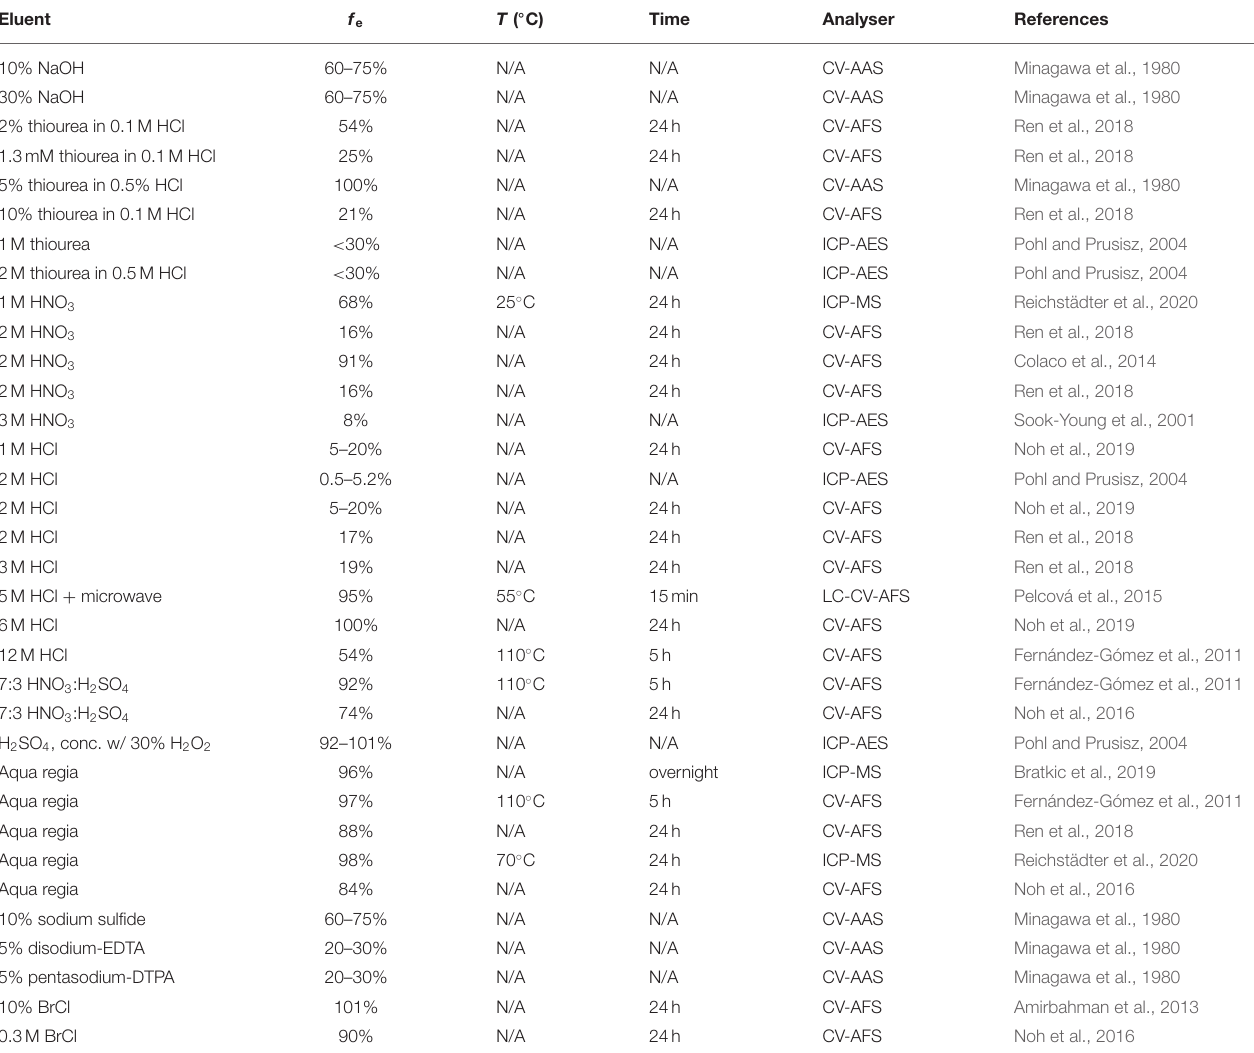
TABLE 5 | Extraction procedures for dissolved labile